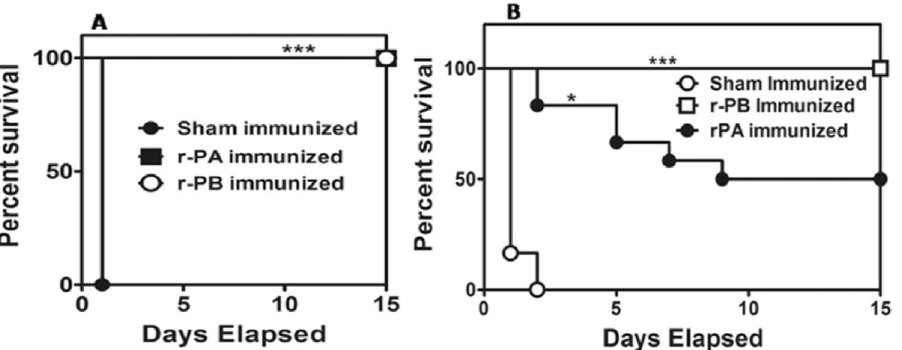
Figure 8. Percentage survival of mice challenged with crude anthrax toxin and spores. Groups of r-PB, r-PA and sham immunized female BALB/c mice (n = 12 each group) were challenged i.p. with 5 × LD 100 units of crude anthrax toxin ( A ) and 10 × LD 50 spores ( B ) on the 45 th day of immunization schedule and survival was monitored for 15 days. The data in ( A ) and ( B ) were generated from three independent experiments. The protective efficacy of r-PB and r-PA subunit vaccine was calculated by Kaplan-Meier graph to compare percentage survival and was found to be statistically significant (p ***